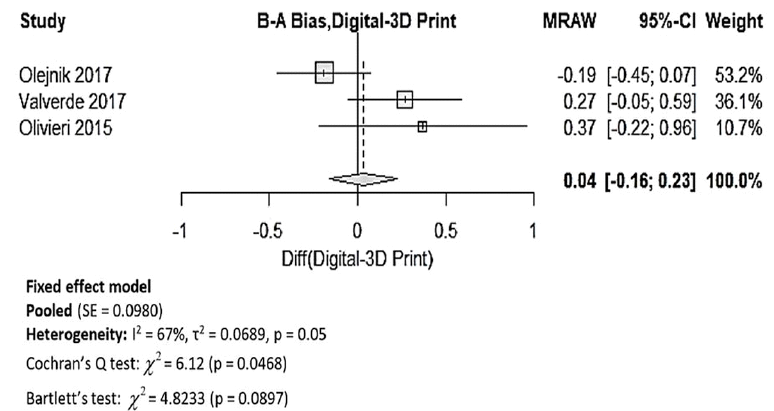
Figure 3. Forest plot for mean bias of the 3DPHM measurement and the digital images measurement. 3D, three-dimensional; B–A, Bland–Altman; MRAW, raw mean difference; CI, confidence interval; SE, standard error.